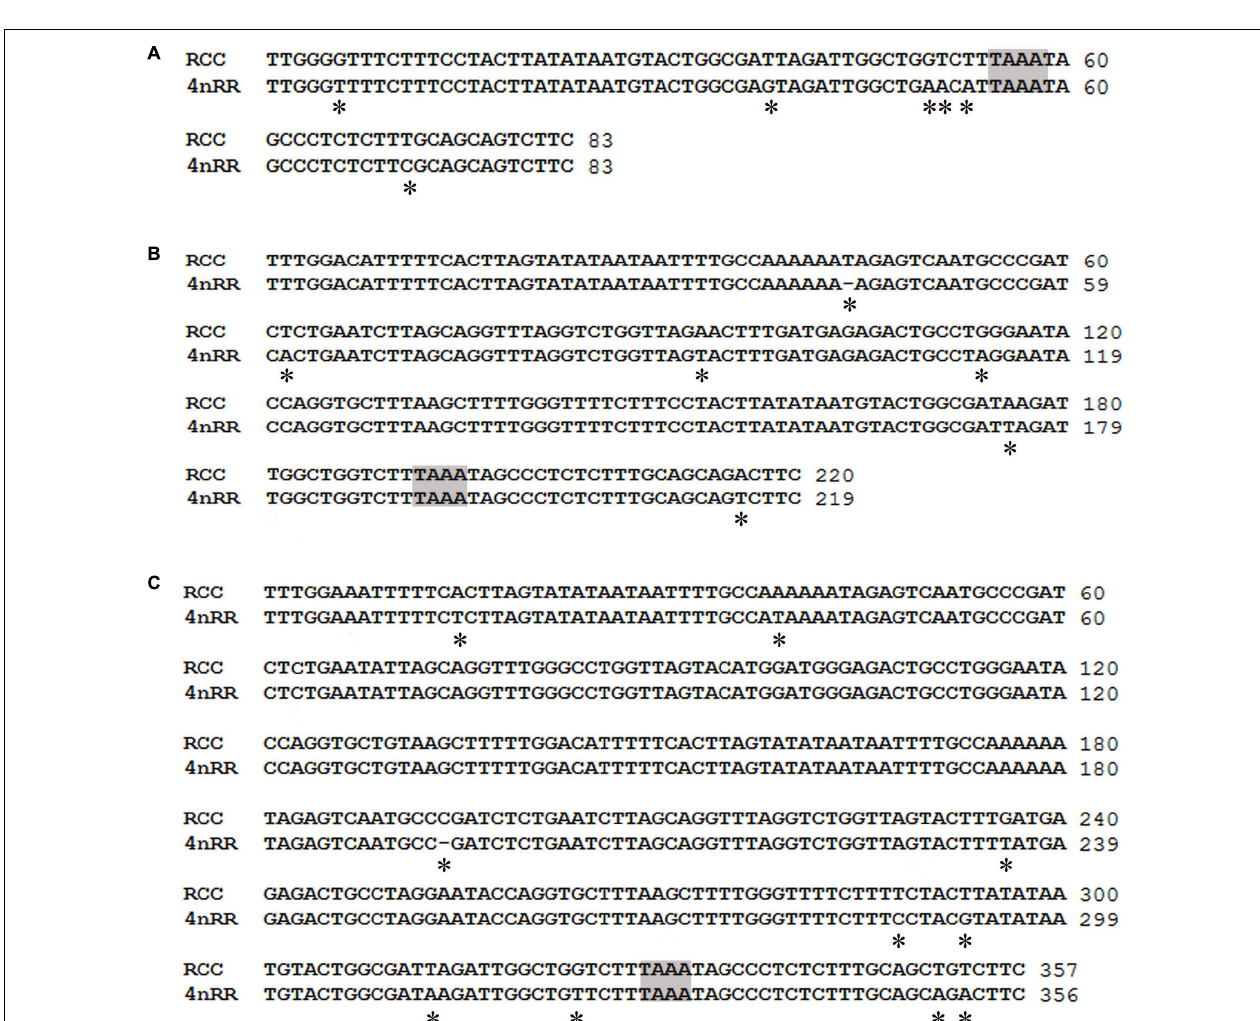
FIGURE 4 | Comparison of the NTS sequences from RCC and 4 n RR. (A) NTS-I sequences from RCC and 4 n RR; (B) NTS-II from RCC and 4 n RR; (C) NTS-III from RCC and 4 n RR. The NTS upstream TATA elements are shaded; asterisks mark variable sites in the NTS.